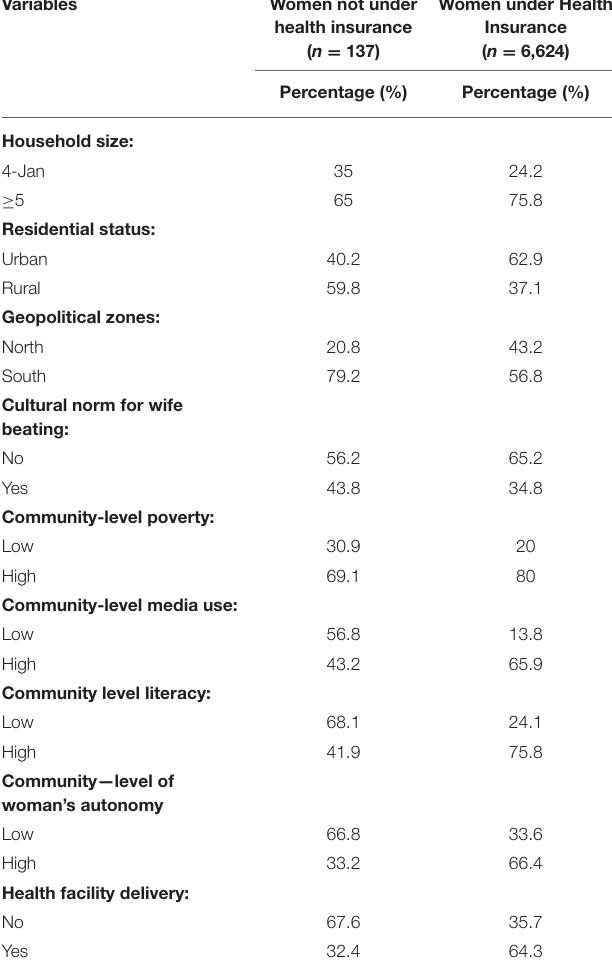
TABLE 1 | Sociodemographic characteristics of